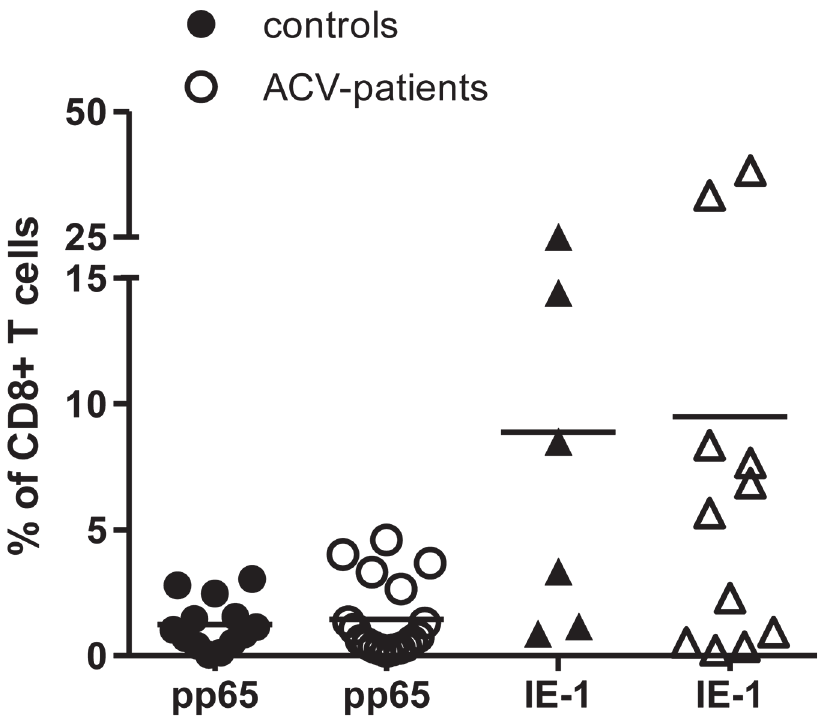
Fig 4. Frequency of pp65 and IE-1-specific CD8+ T cells detected by HLA-peptide tetramer staining in control subjects and donors taking acyclovir. PBMC were stained with HLA-peptide tetramers specific for pp65- and IE-1-derived epitopes according to the individual HLA genotype. The aggregate frequency of pp65 or IE-1-binding T cells was determined for each donor and is shown in the figure. Horizontal bars depict the mean